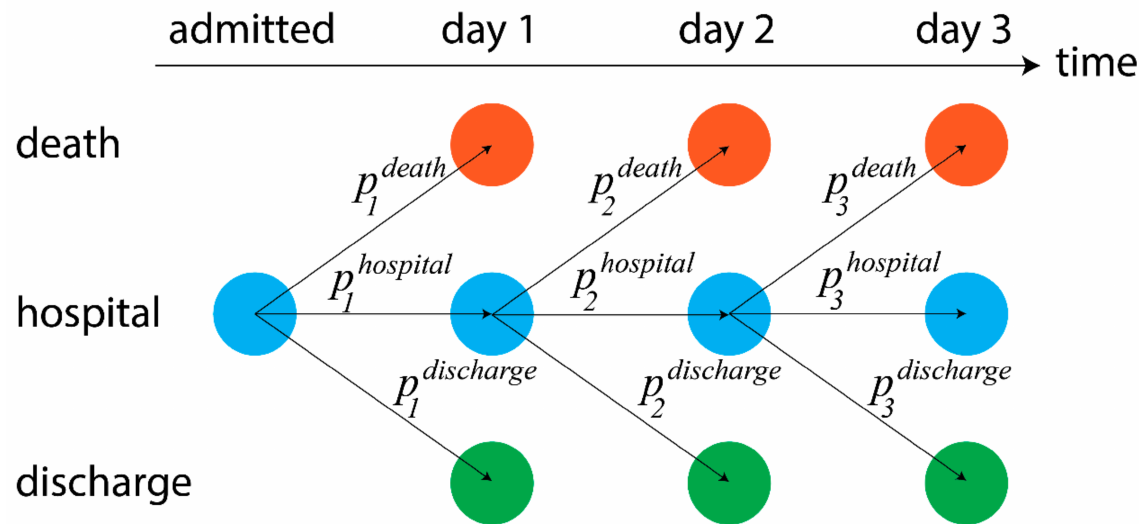
Figure 1. Markov model schematic: colors indicate each of the three distinct states. Arrows indicate potential changes in the patient’s state from one day to the next. These state transitions are influenced by probabilities which, in the model, can vary with patient characteristics, timing of their admission, initial lab values and dynamic changes in